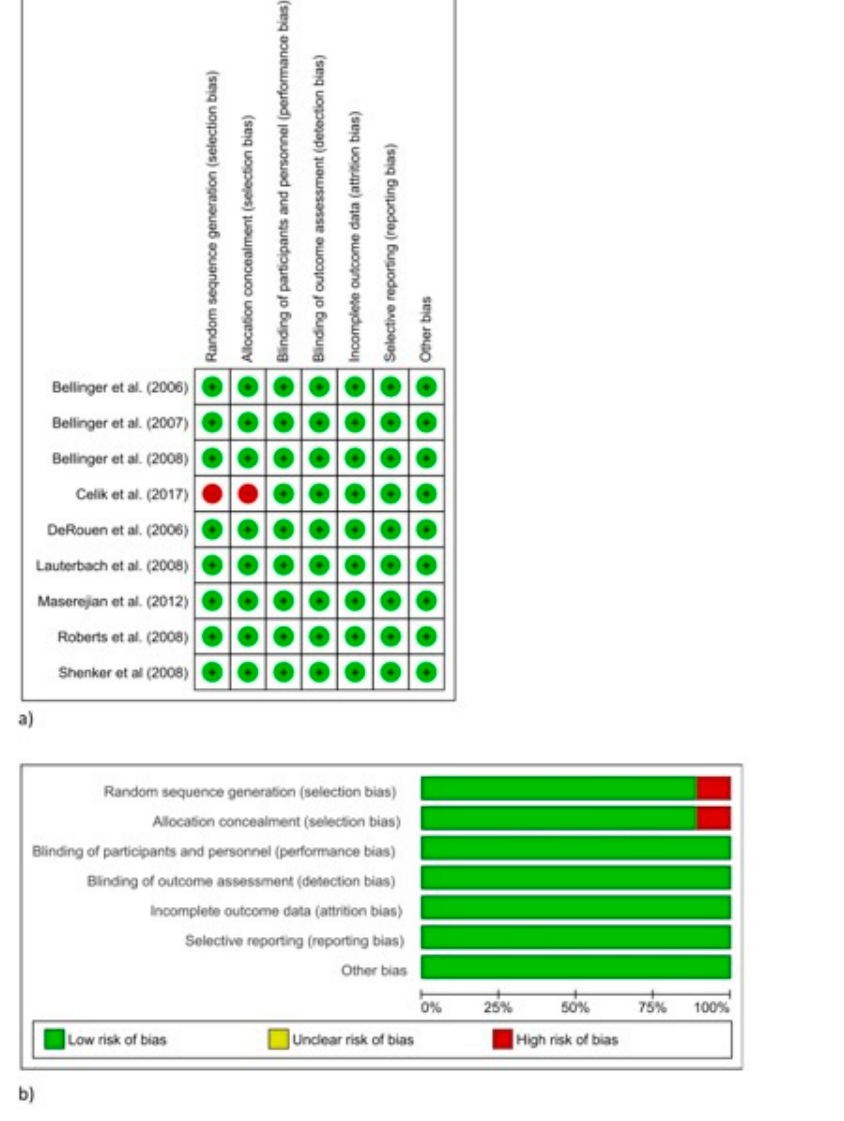
Figure 1. Risk of bias summary of the included studies using the Cochrane collaboration’s tool [35]. ( a ) Presented for each included study. ( b ) Presented as percentages across all included studies. A green circle/area indicates a low risk of bias for the study regarding the specific domain, a red circle/area indicates a high risk of bias, and a yellow circle/area indicates that the risk is un- clear.